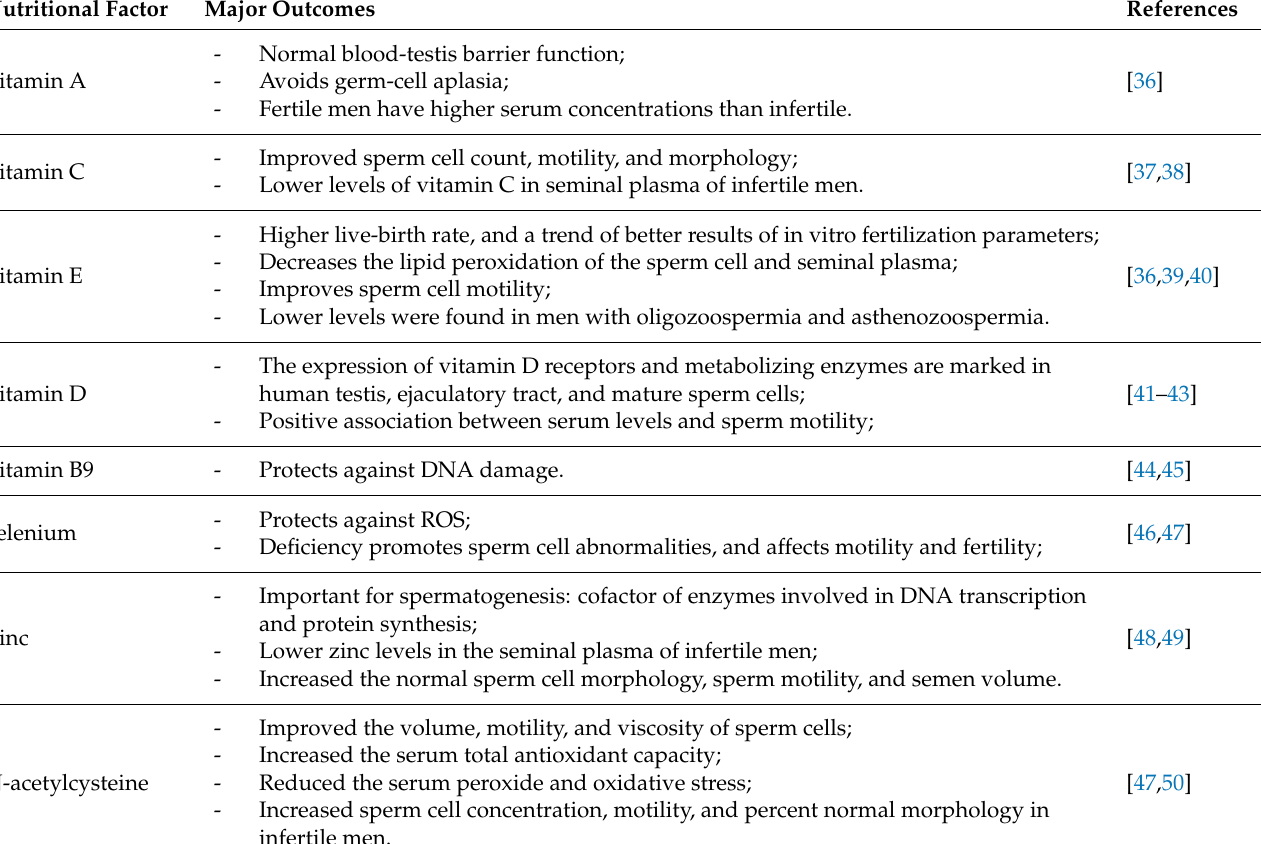
Table 1. BFCs and their major outcomes on human sperm quality and